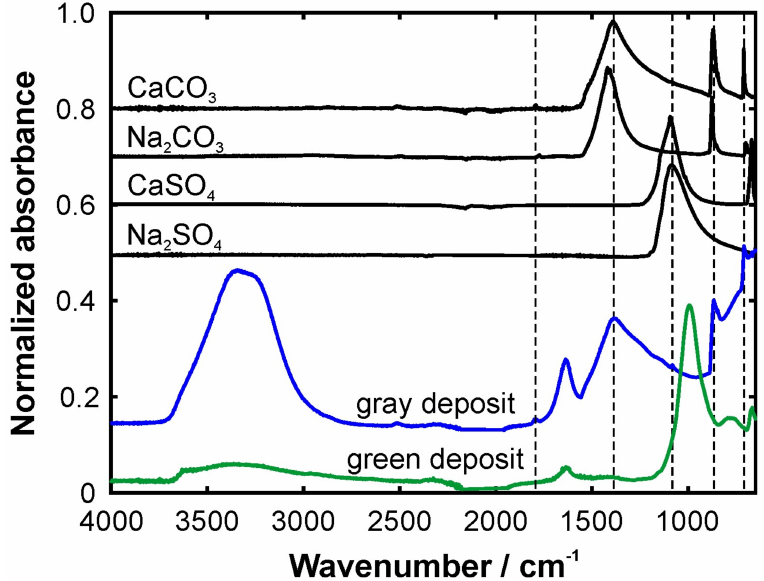
Figure 3. FTIR spectra of the two different deposits from the water cooker in comparison with selected reference spectra. The dashed vertical lines are a guide to the